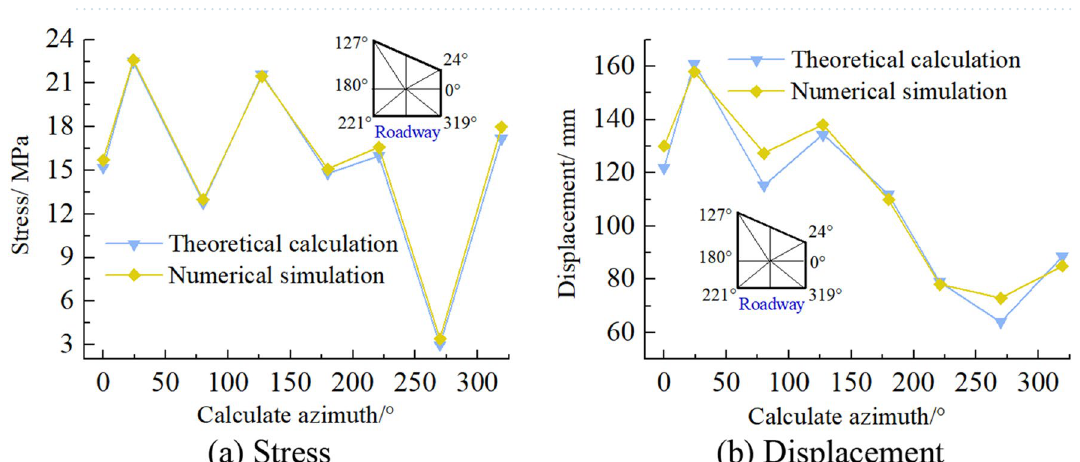
Figure 21. Roadway plastic zone.